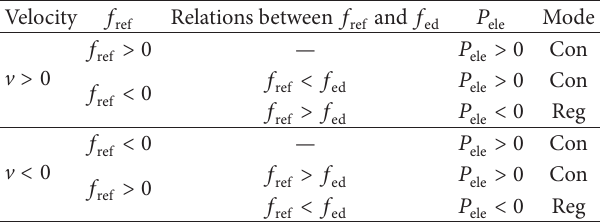
Table 1: Comparison between motor thrust and damping